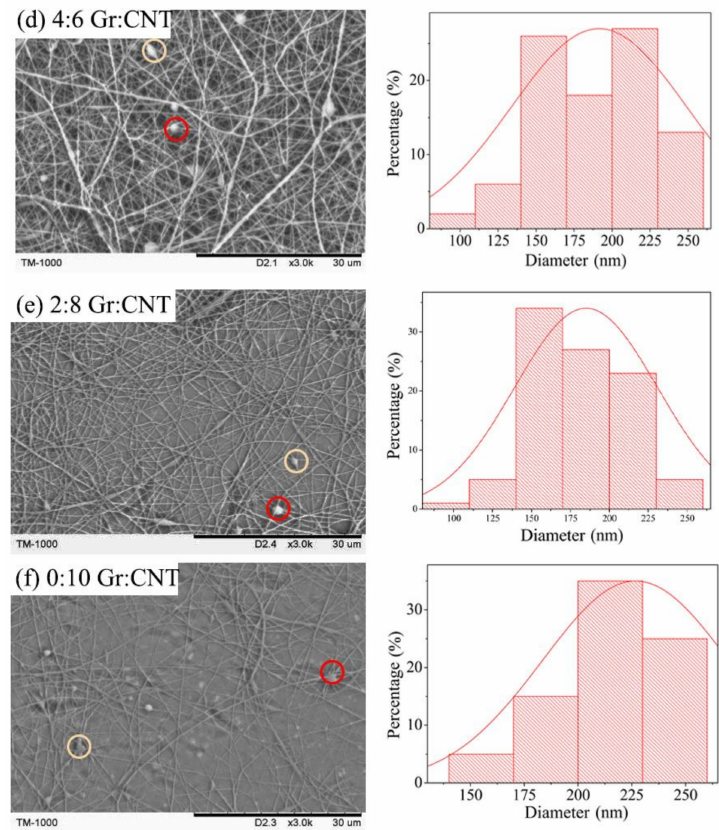
Figure 3. SEM images and diameter of PVA / SA / Gr / CNT nanofibers membranes with the Gr-CNT ratios of ( a ) 10:0, ( b ) 8:2, ( c ) 6:4, ( d ) 4:6, ( e ) 2:8, ( f )